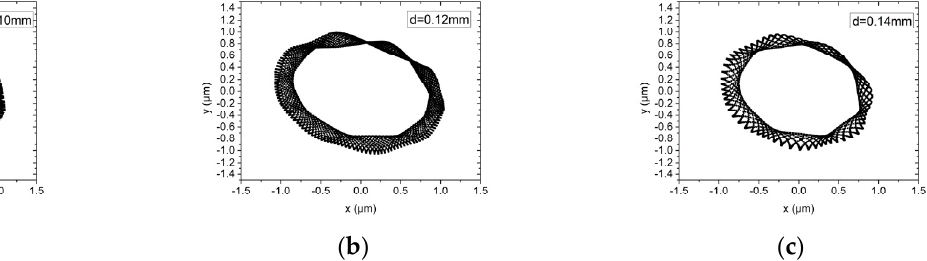
Figure 13. Rotor center trajectory under different orifice diameter under working condition 5 (high speed, dynamic unbalance G1). ( a ) Rotor center trajectory ( d = 0.10 mm), ( b ) rotor center trajectory ( d = 0.12 mm), ( c ) rotor center trajectory ( d = 0.14 mm).